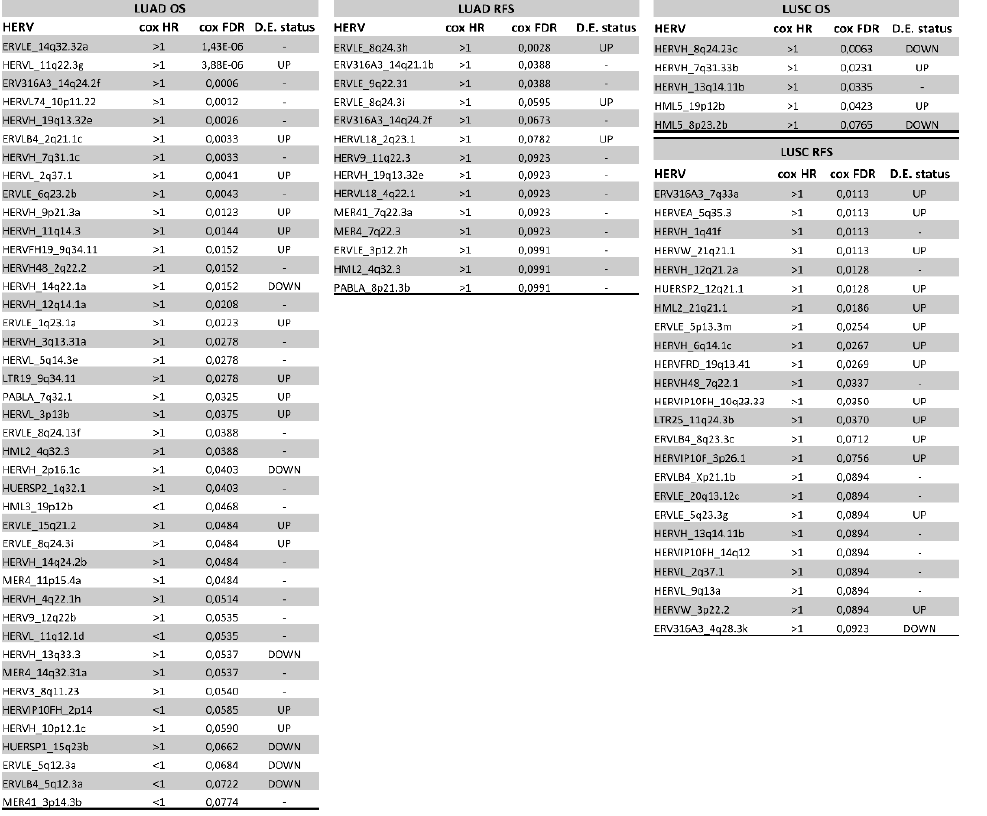
Figure 6. Tables showing the list of HERVs statistically associated with overall survival (OS) and relapse-free survival (RFS) in both TCGA − LUAD and TCGA − LUSC cohorts. In more detail, Cox hazard ratios (HR), and Cox false discovery rates (FDR) values are reported. In addition, it is also reported for each HERV if it has been found up − regulated (up) or down − regulated (down) during the paired tumor vs. normal differential HERV expression analysis.